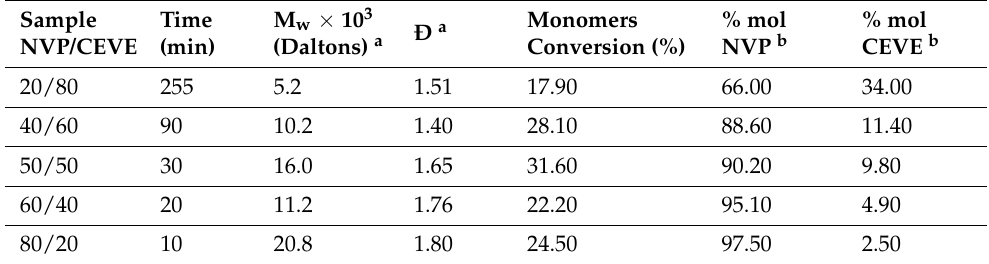
Table 2. Molecular characteristics of P(NVP–stat–CEVE) for the calculation of the monomer reactiv- ity